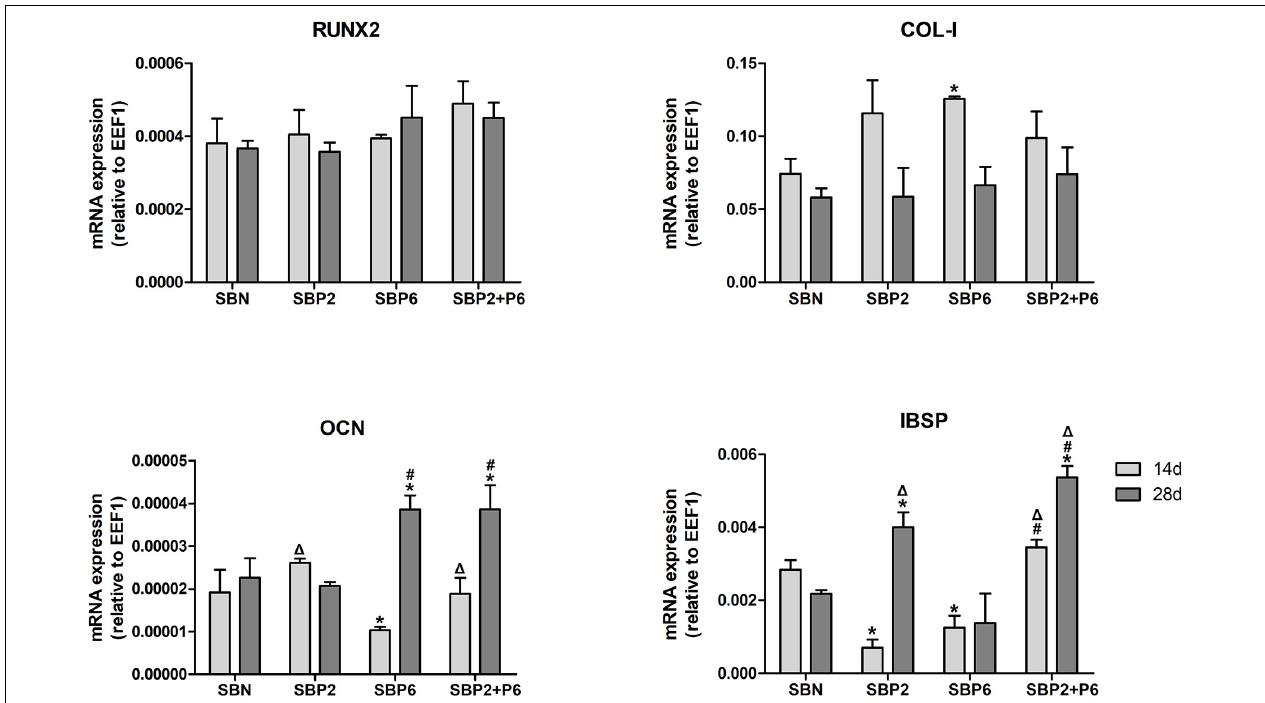
FIGURE 5 | Osteogenic related gene expression analyzed via qPCR. * p < 0.05 for when compared to SBN, # p < 0.05 for when compared to SBP2, (cid:49) p < 0.05 for when compared to SBP6 ( n =